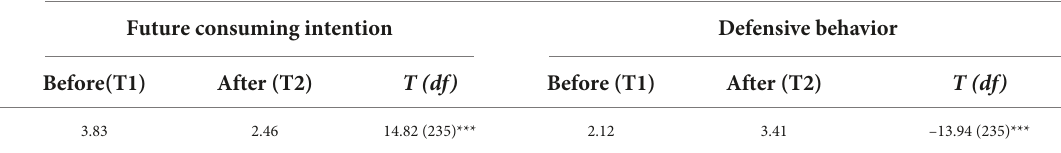
TABLE 2 Results of mean comparisons and regression